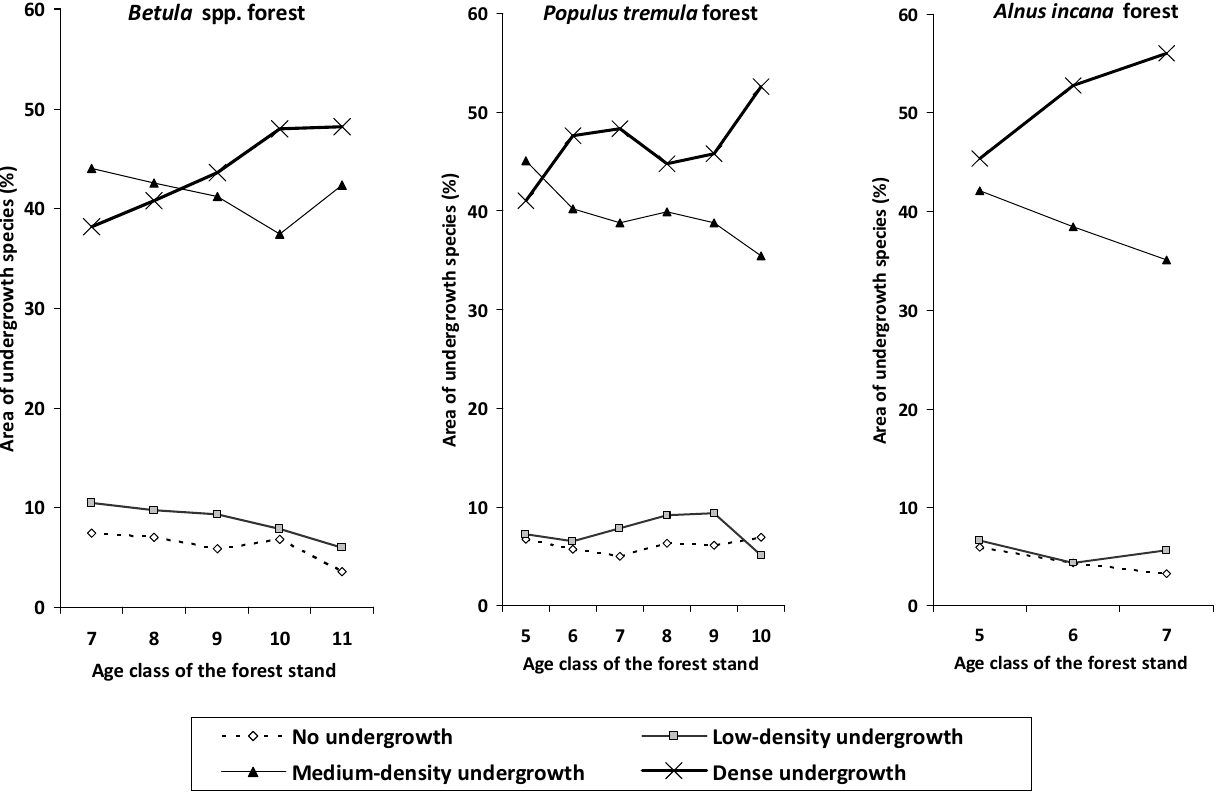
Figure 6. Changes in the undergrowth species areas in the Betula spp., Populus tremula, and Alnus incana forest stands, representing different tree age classes of the main stand story. The stand age structure shown on the y -axis means, for example, that class 7 includes stands from 61 to 70 years old, age class 8 includes stands from 71 to 80 years old, etc.